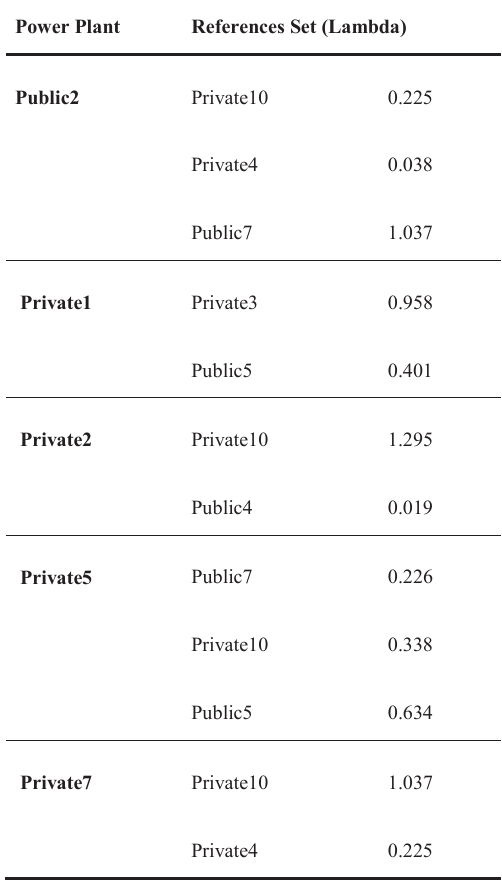
Table 4. Reference sets of Inefficient Power Plants Power Plant